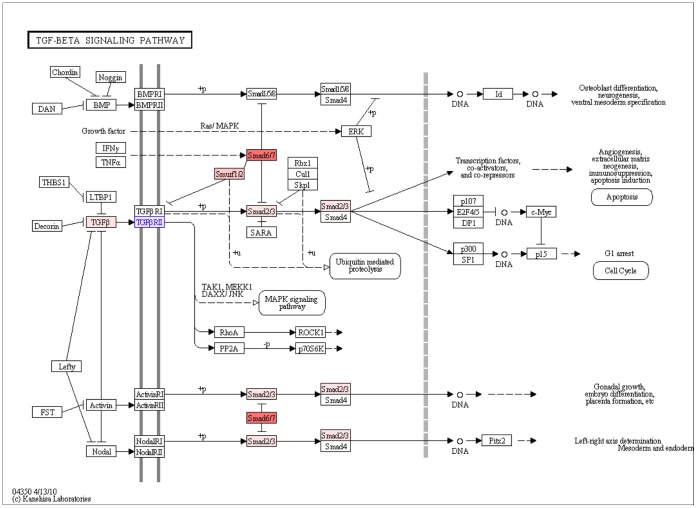
KEGG pathway map for TGF-beta signaling pathway.The shade of red color in genes indicates the number of targeted SNPs in JP population per base pair of the gene. Red refers to the highest targeted gene, whereas white refers to a gene product, not targeted by the SNPs. Blue border indicates that the gene is found to be differentially expressed.